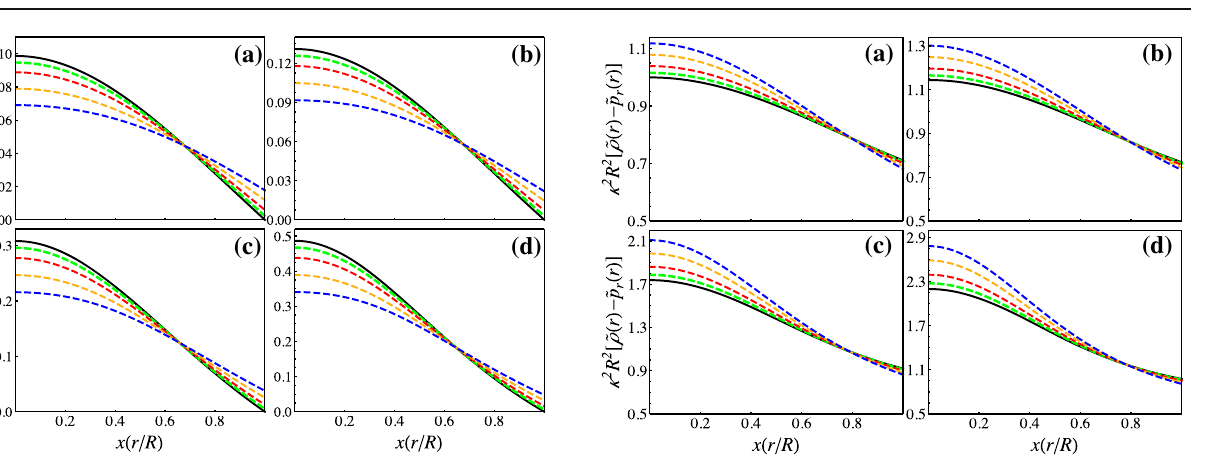
Fig. 5 Dominant energy condition for the radial components, for a u = 0 . 13, b u = 0 . 15478, c u = 0 . 2035, d u = 0 . 229365. α = 0 (black solid line), α = 0 . 04, (green dashed line), α = 0 . 1 (red dashed line), α = 0 . 2 (yellow dashed line), α = 0 . 3 (blue dashed line)